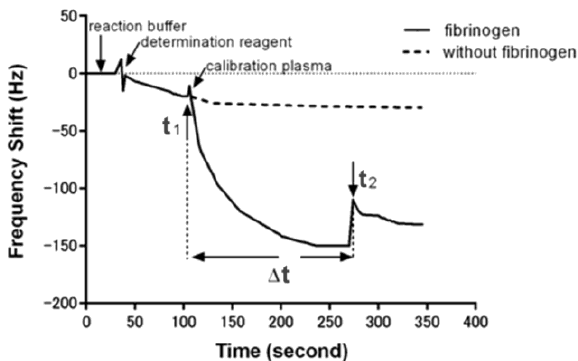
Figure 1. The real-time QCM biosensor detection diagram of the